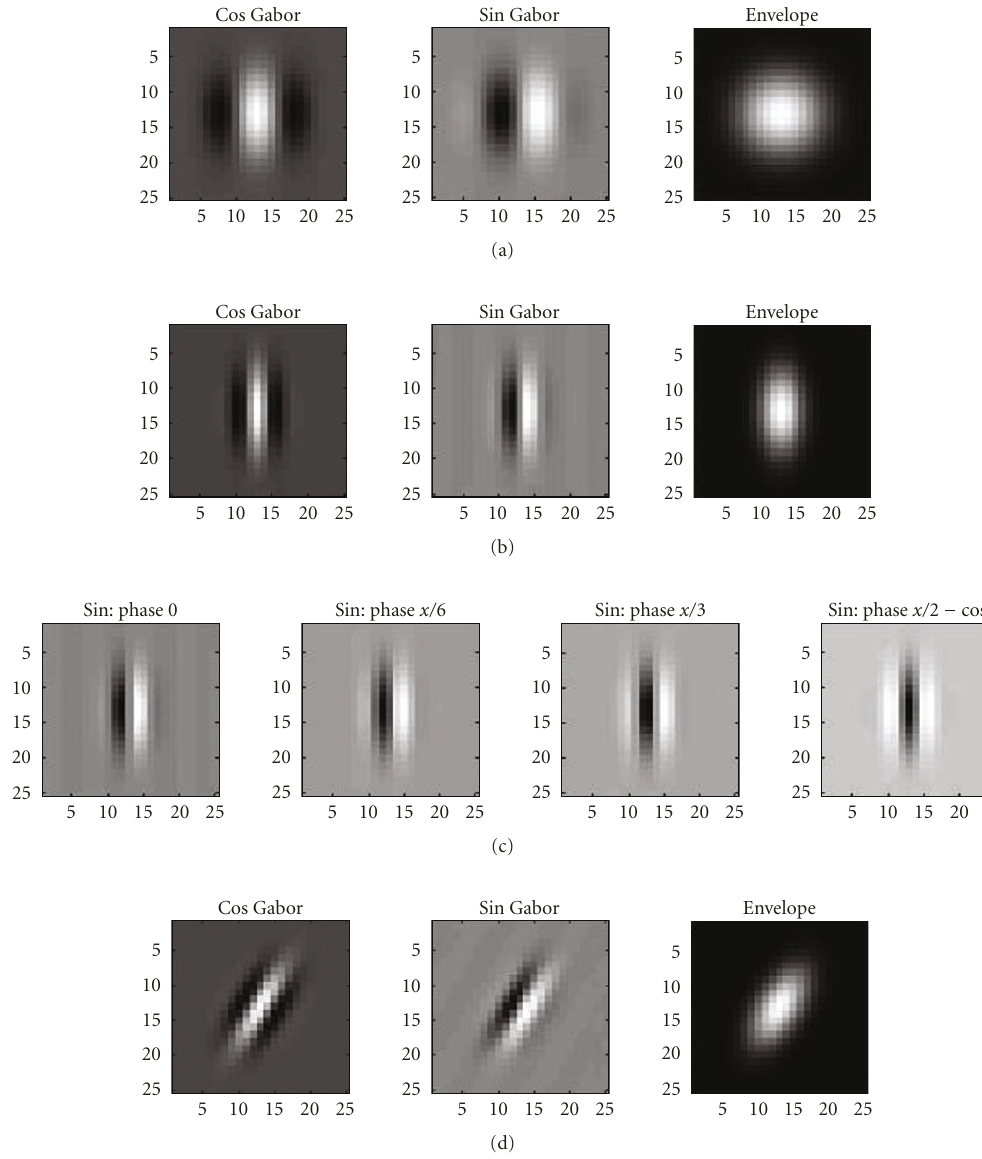
Figure 5: Gabor patches, illustrating e ff ects of parameter changes, notably angular selectivity (elongation), phase, and rotation. (a) σ x = σ y ; (b) σ x = σ y / 2; (c) left to right, increasing phase shift and Gabor transformed from antisymmetric to symmetric.